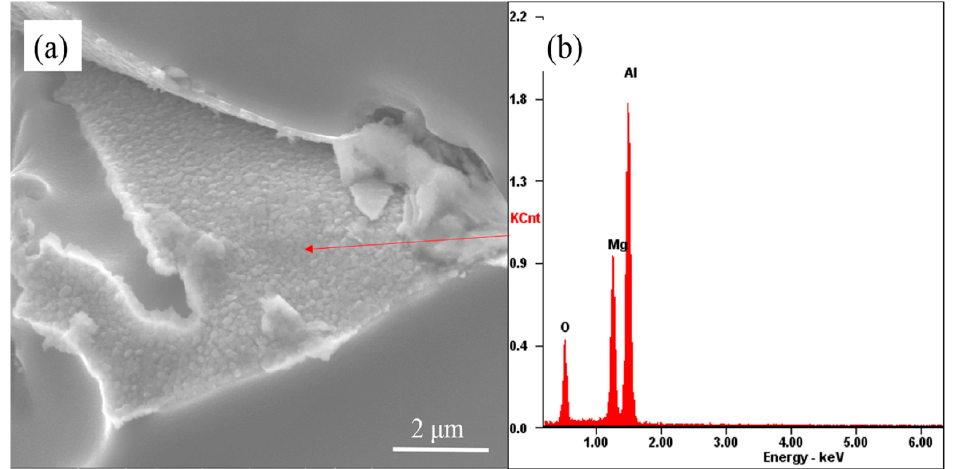
Figure 12. ( a ) The micro-morphology of 5083 alloy scraps after being held in Al-4.5Mg alloy melt for 15 min; ( b ) Corresponding EDS